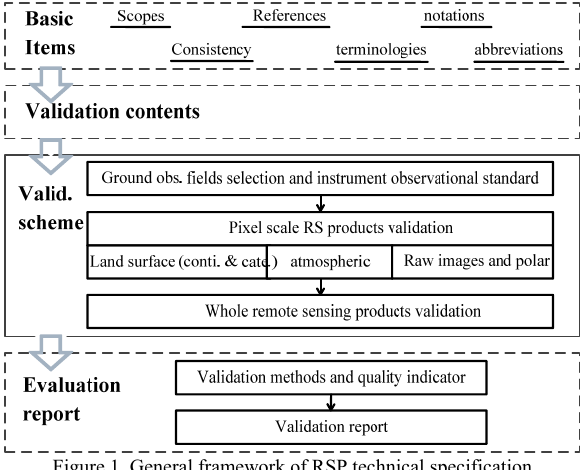
Figure 1. General framework of RSP technical specification